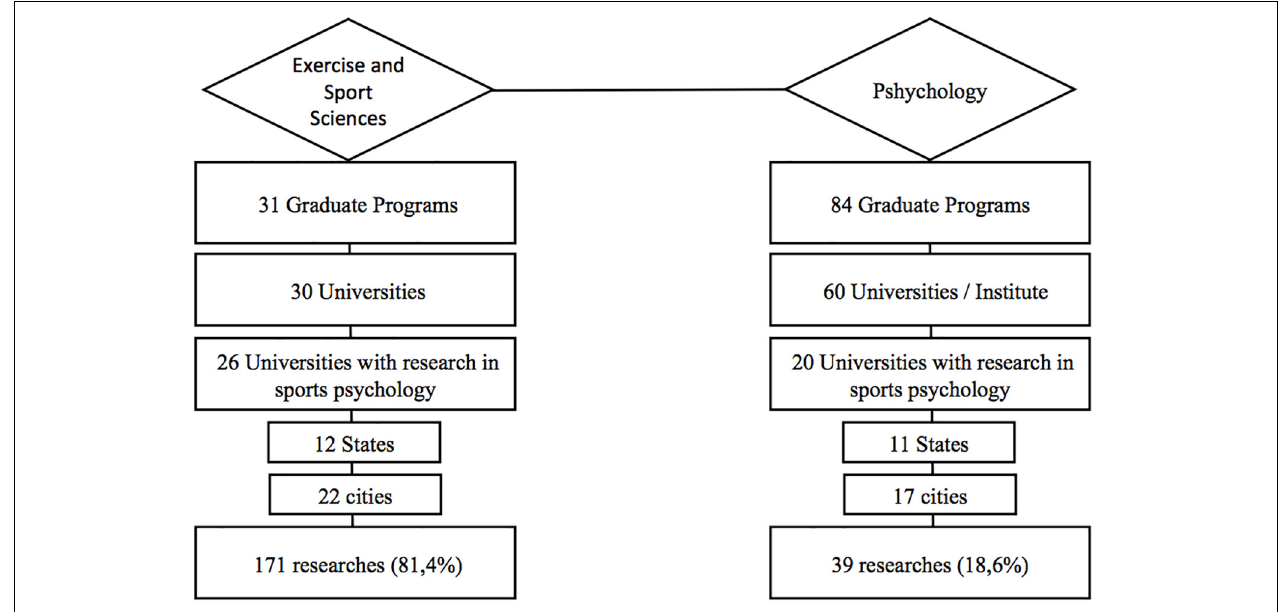
FIGURE 2 | Distribution of institutional researches in Sport and Exercise Psychology from Exercise and Sport Science and Psychology graduate programs in Brazil.